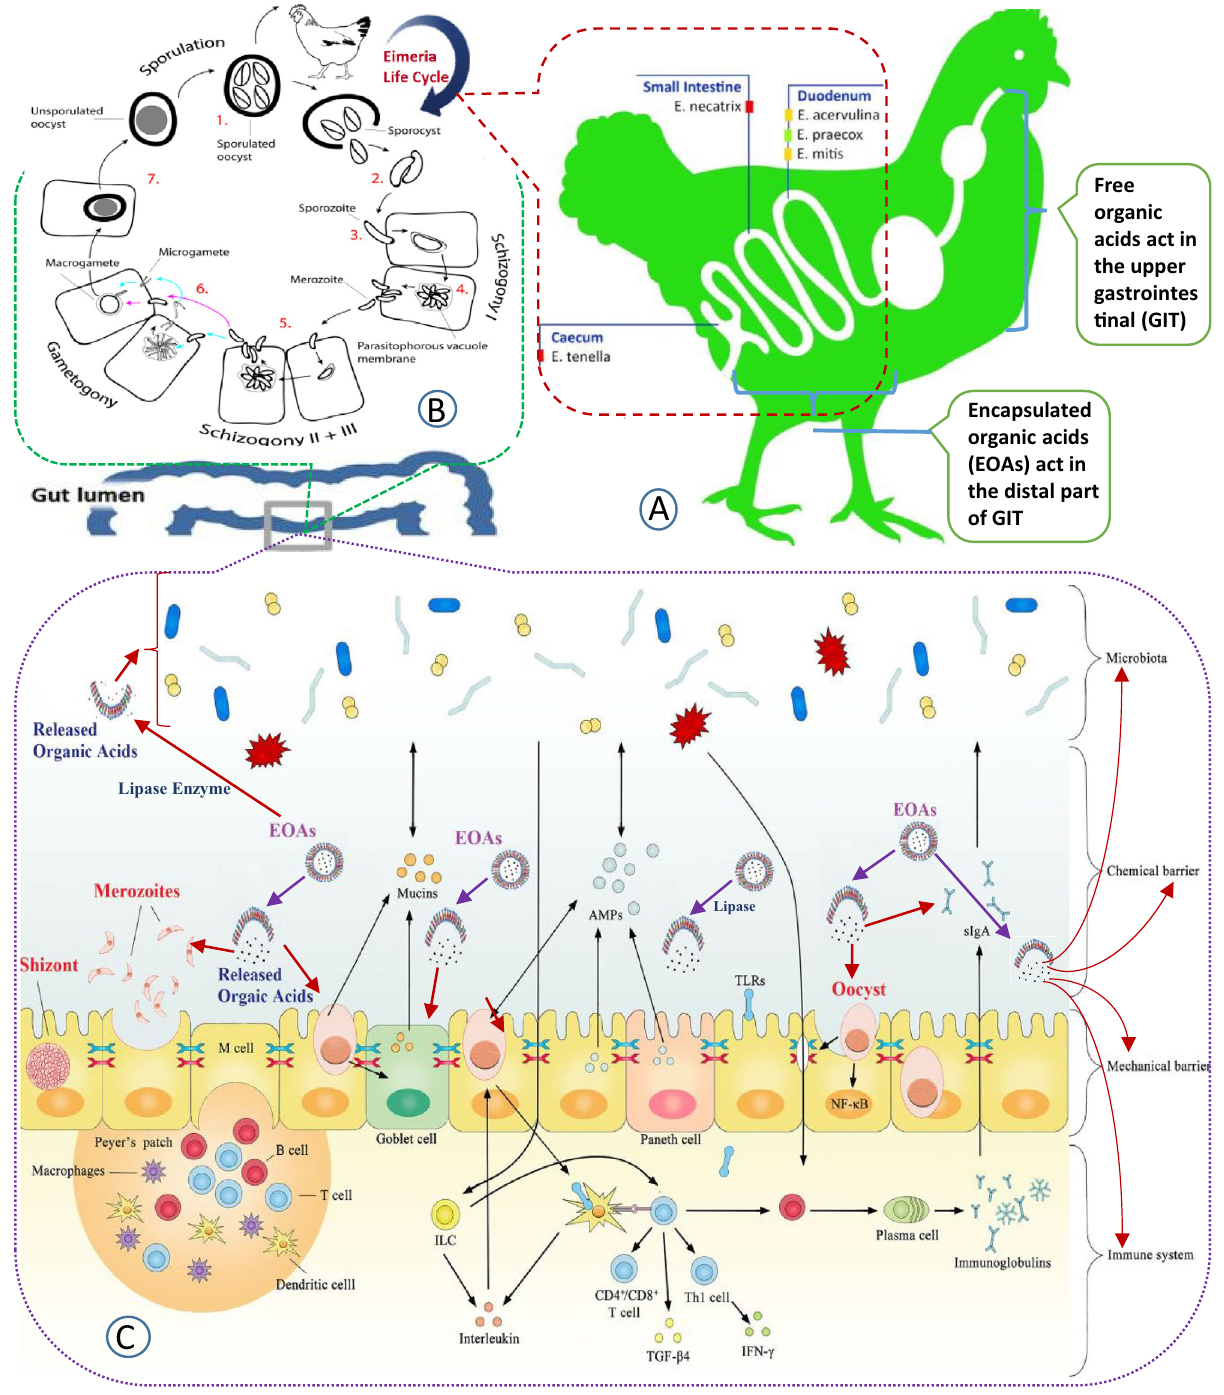
Figure 2. Summary of activity portions, mechanisms and effects of EOAs in the infected broilers’ gastrointestinal